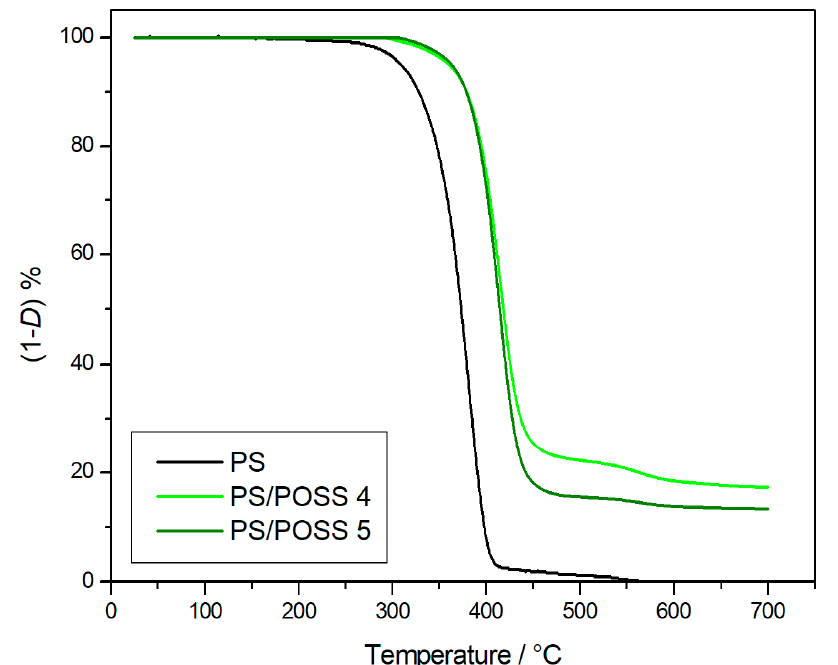
Figure 5. Thermogravimetric curves, in an oxidative atmosphere, for PS and samples 4 and 5 .